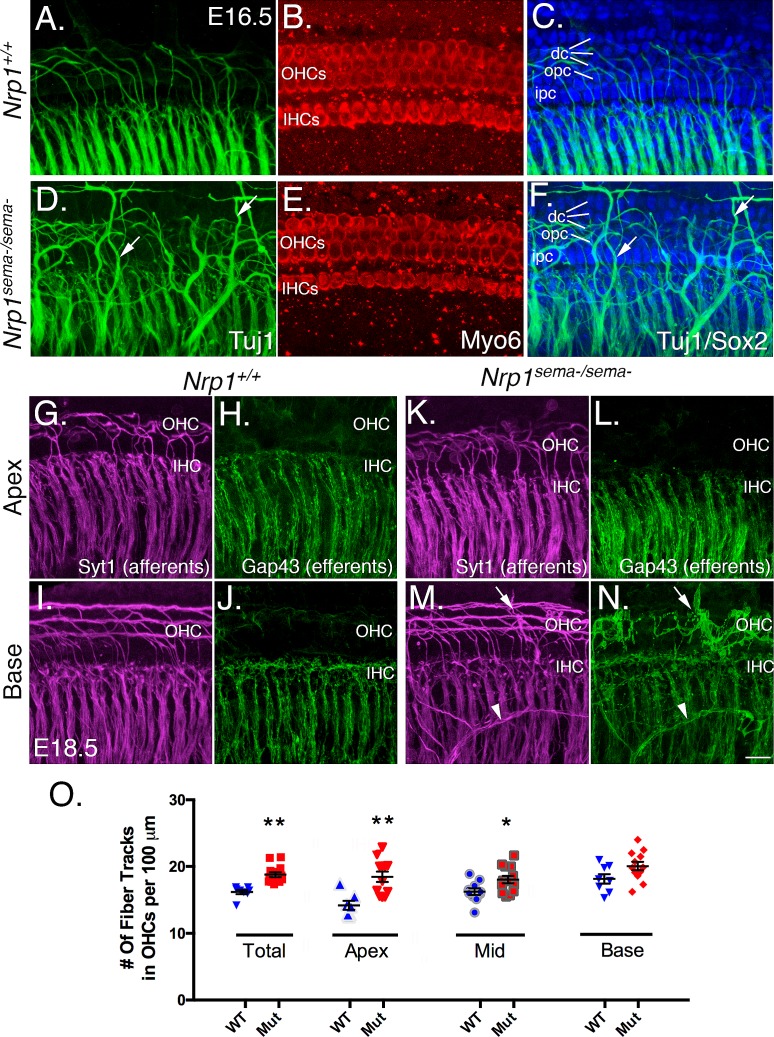
Loss of sema-mediated activation of neuropilin-1 causes increased sensory domain innervation.(A-F) Whole mount samples from E16.5 cochleae from WT and Nrp1sema-/sema- mice. Neurons were stained with anti-TUJ1 antibodies (green) and hair cells were stained with anti-Myo6 antibodies (red). The arrows in D and F point to excessive nerve fibers innervating the hair cell region. Panels C and D show TUJ1 labeling with Sox2 immunolabeling, which identifies the different supporting cell types. OHC, outer hair cell; IHC, inner hair cell; dc, Deiters’ cell; opc, outer pillar cell; ipc, inner pillar cell. (G-N) Analysis of SGN afferents (Syt1 staining; magenta) and olivocochlear efferents (Gap43 staining; green) from E18.5 cochleae from WT and Nrp1sema-/sema- mice. The arrows in panels M and N point to an aberrant nerve fiber in the OHC region of Nrp1sema-/sema- cochleae. The arrowheads in M and N point to a cluster of nerve fibers that appears to be traversing across the cochlear radial fibers in an unusual manner. (O) Panel O showing that loss of Sema-mediated activation of neuropilin-1 can lead to a significant increase in Syt+ SGN processes projecting into the OHC region.